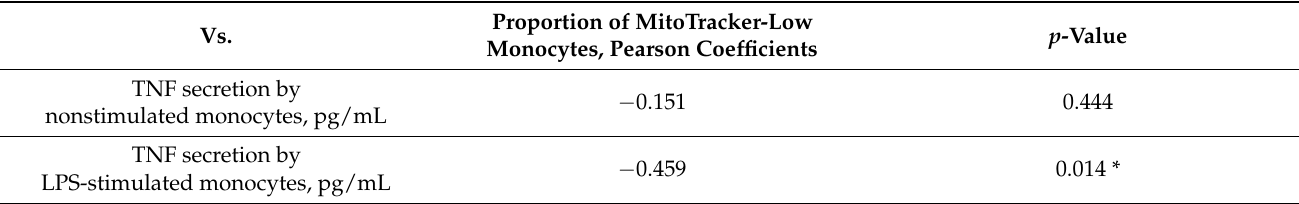
Table 2. Correlation analysis of MitoTracker staining intensity with cultured monocyte proinflammatory activation ability.